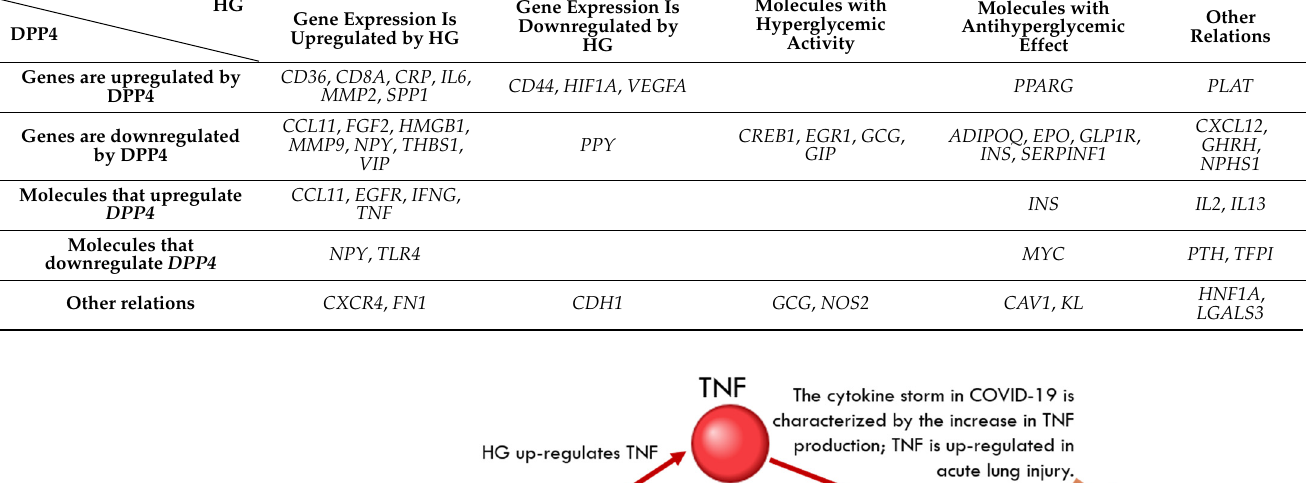
Table 4. Types of associations of the genes/proteins from hyperglycemia-related and DPP4-related networks with high glucose (HG) and DPP4.